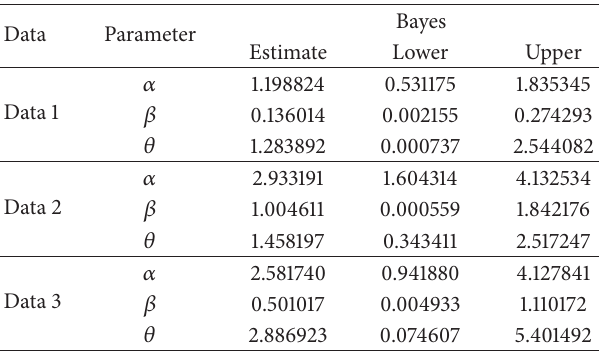
Table 3: Bayes estimates and 95% HPD credible intervals for the model parameters based on real data